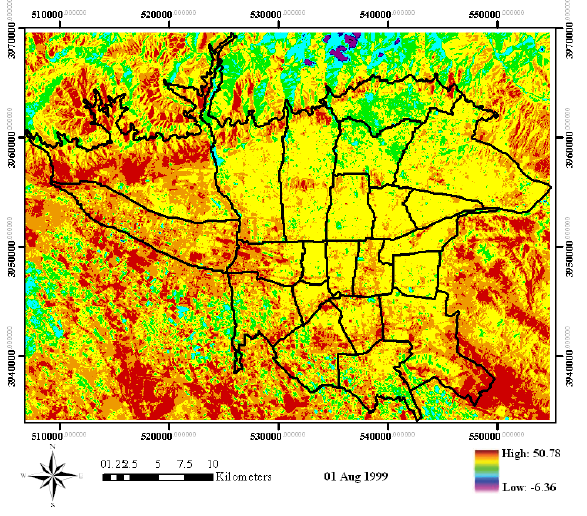
Figure 2. The map of LST of the Tehran metropolis (1 August 1999)